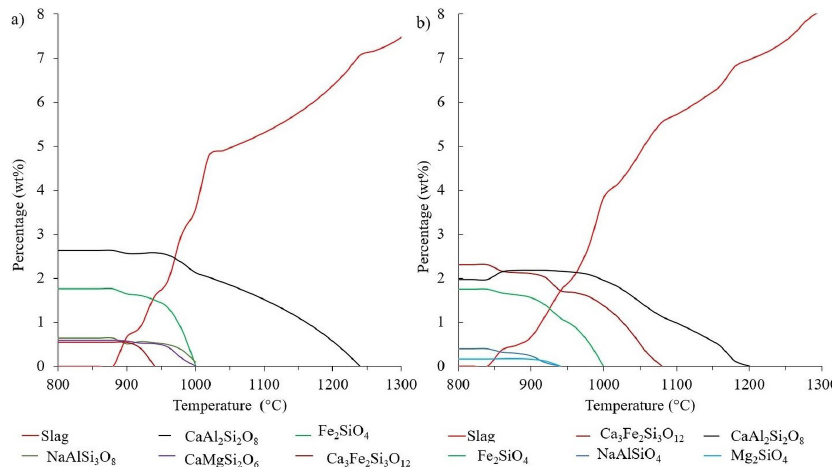
–C –B and b) pellet Ba 0.45 0.5 0.7